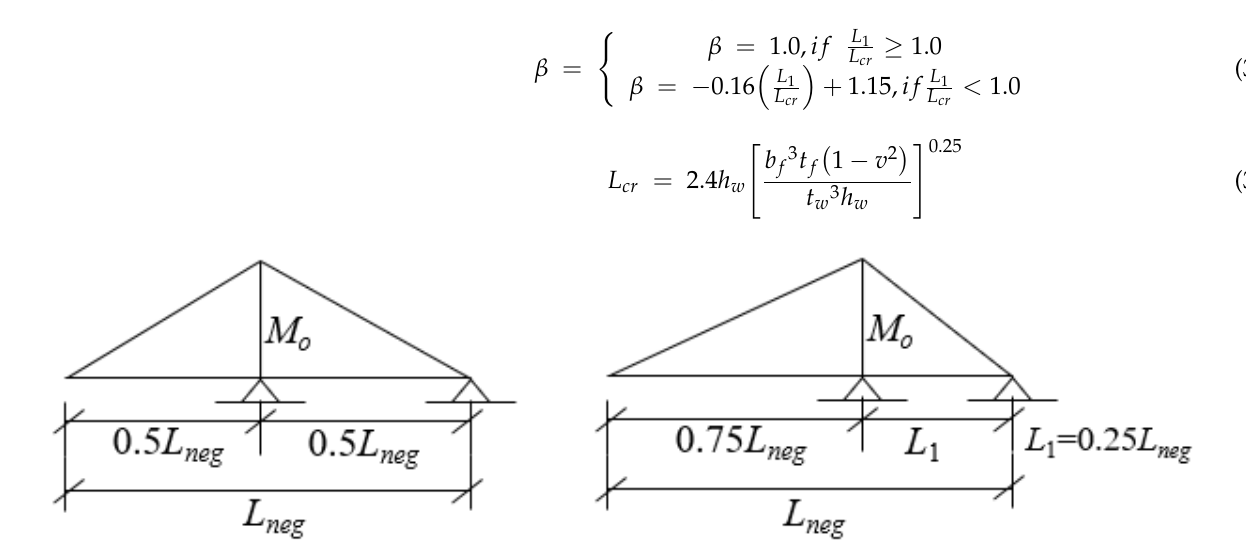
Figure 13. Possible positions of supports for different hogging moment diagrams. Adapted from Oliveira [123].